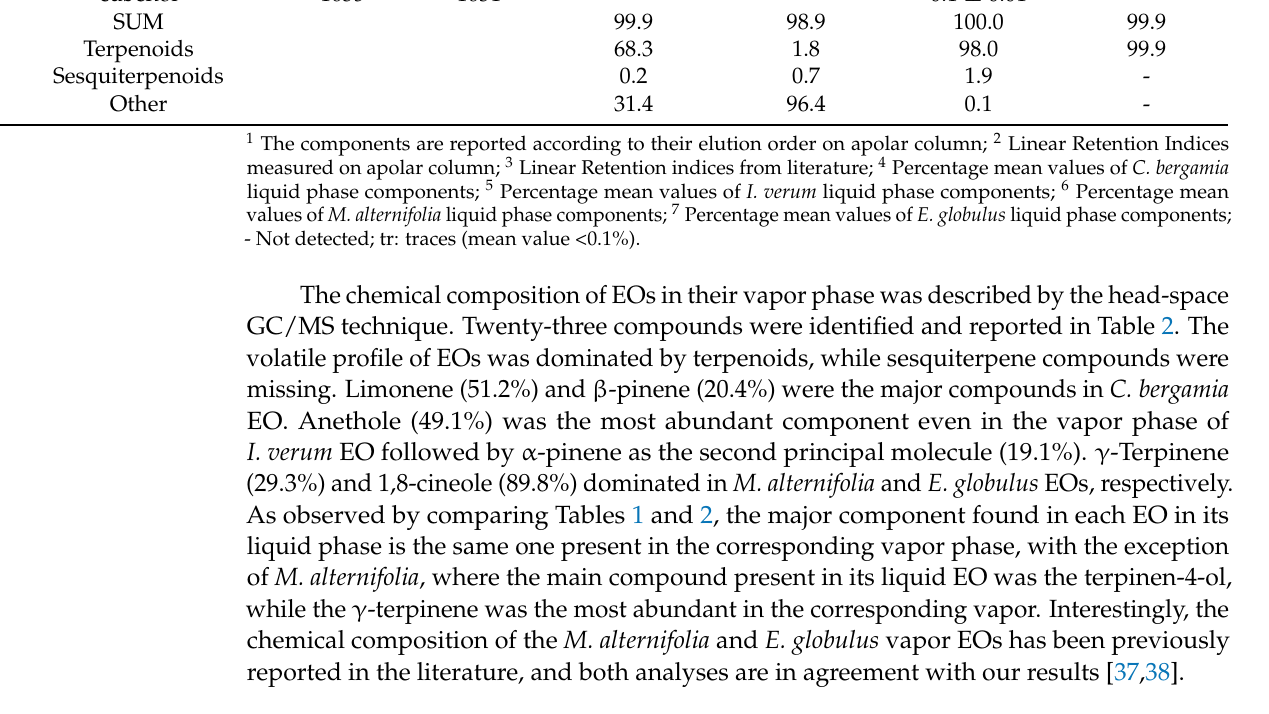
Table 2. Chemical composition of volatiles (percentage mean value ± standard deviation) of